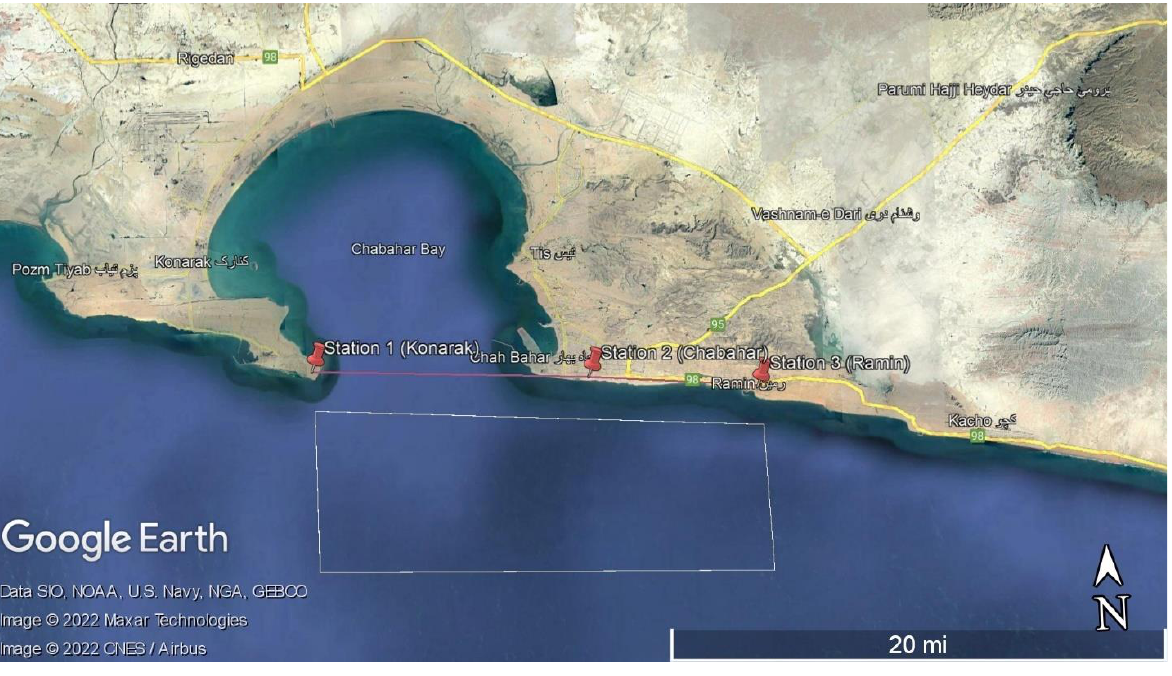
Figure 7. Suggested